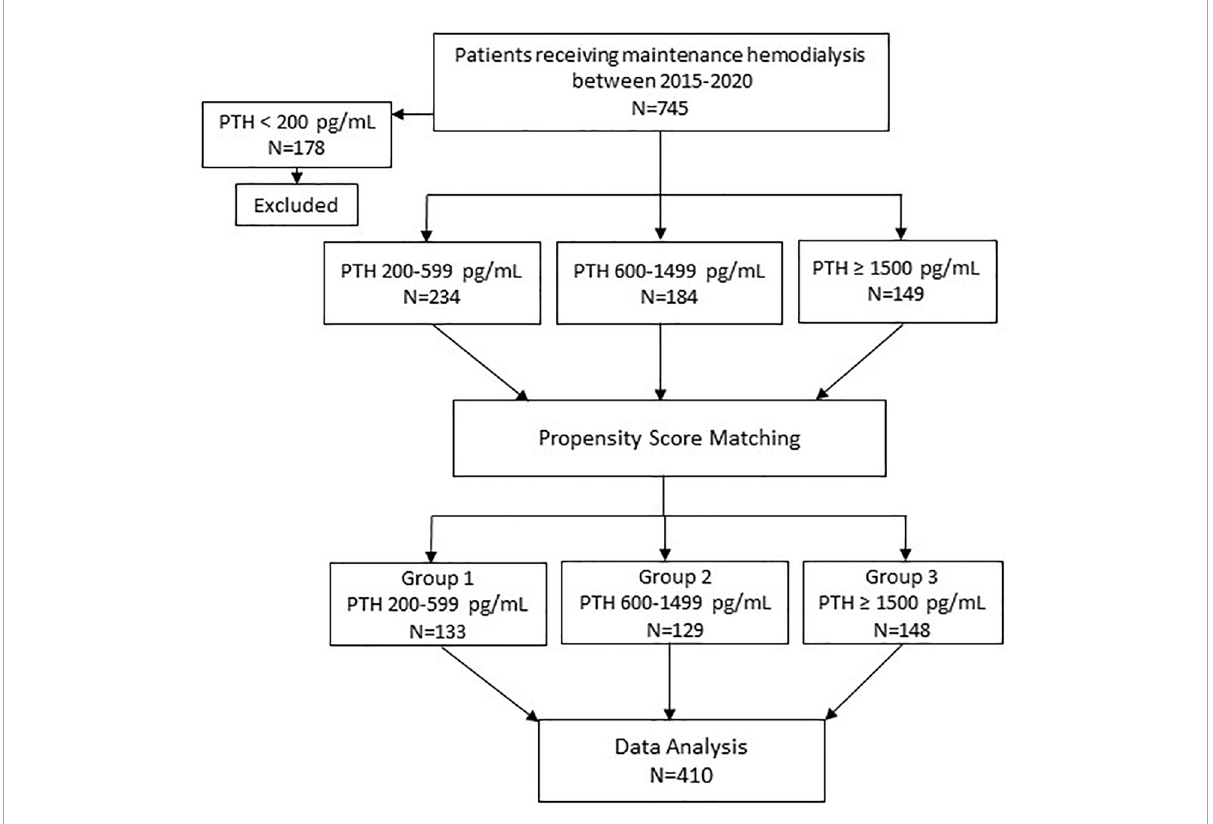
FIGURE1 Study flow chart. PTH, parathyroid hormone.